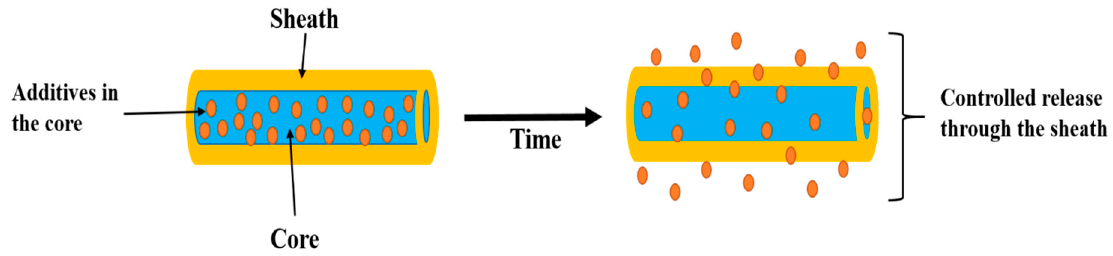
Figure 2. Schematic view showing the encapsulation and release procedure [50] .